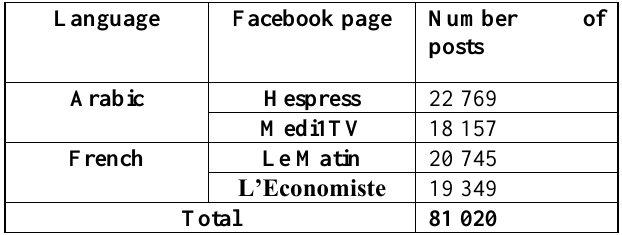
Table 2. Description of the data.